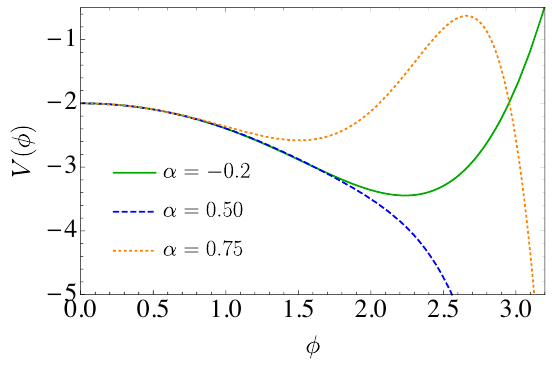
Figure 1 . Potential (3.5) for three different holographic RG